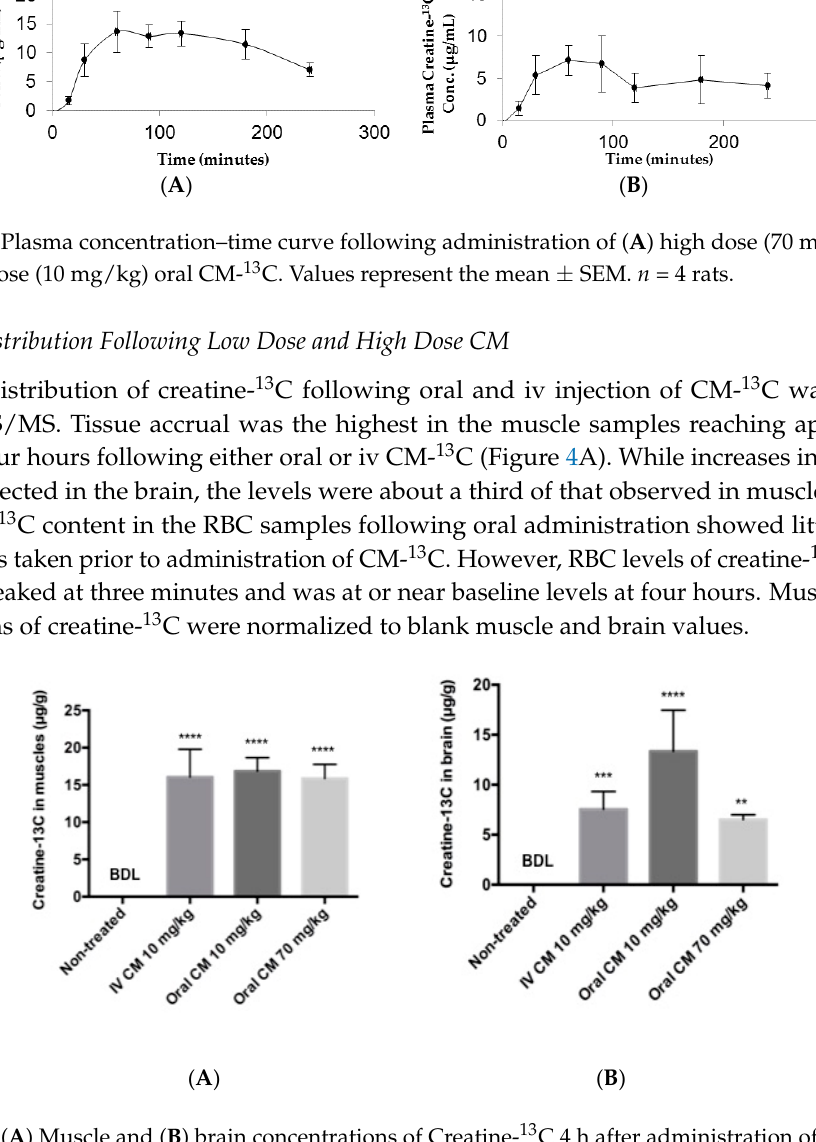
Figure 2. Plasma 13 C-creatine concentration vs time curves following intravenous administration of CM- 13 C in adult male rats. The curves are shown in both linear ( A ) and semi-log ( B ) formats. Values represent the mean ± SEM. n = 4 rats.